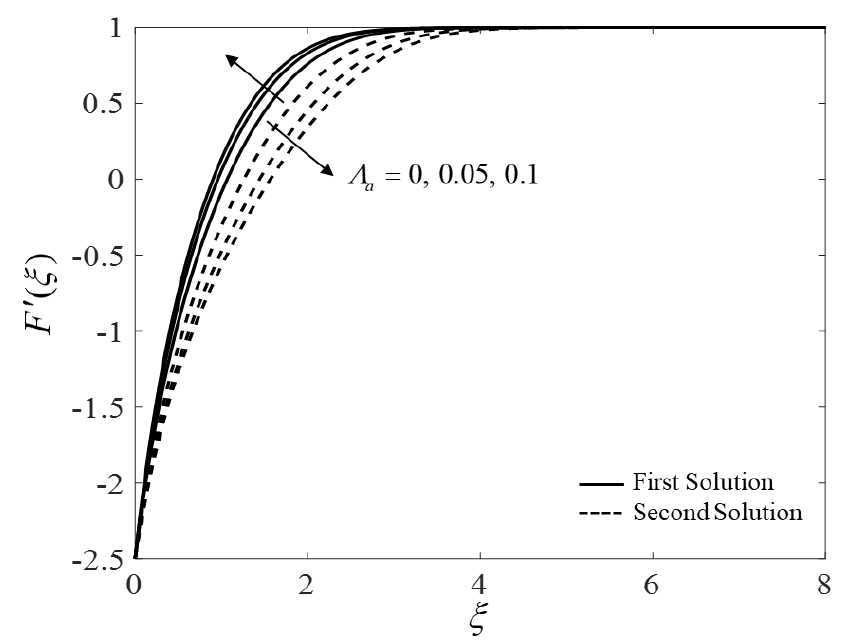
Figure 9. Velocity profile F (cid:48) ( ξ ) for different values of Λ a .